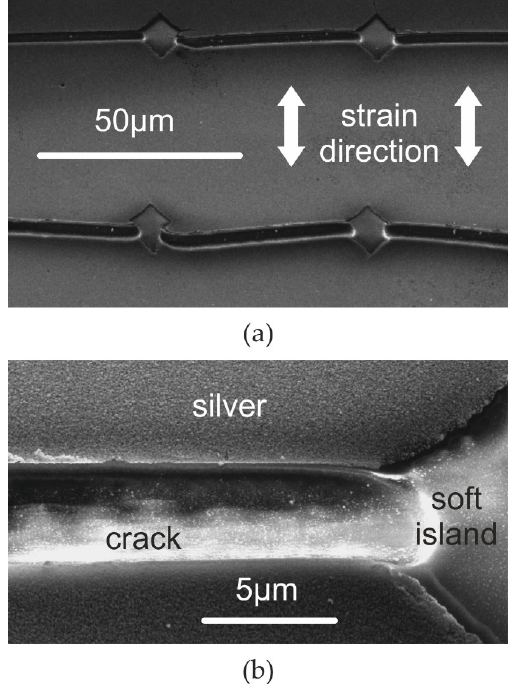
Figure 3. Scanning electron micrographs of PDMS surface with controlled cracks kept under tensile strain of 10% during silver deposition and at the same strain during electron microscopy: ( a ) four soft islands after controlled cracking; ( b ) a single controlled crack and the transition between crack and soft island (note, in contrast to Figure 2, the pattern shown here is coated with silver).